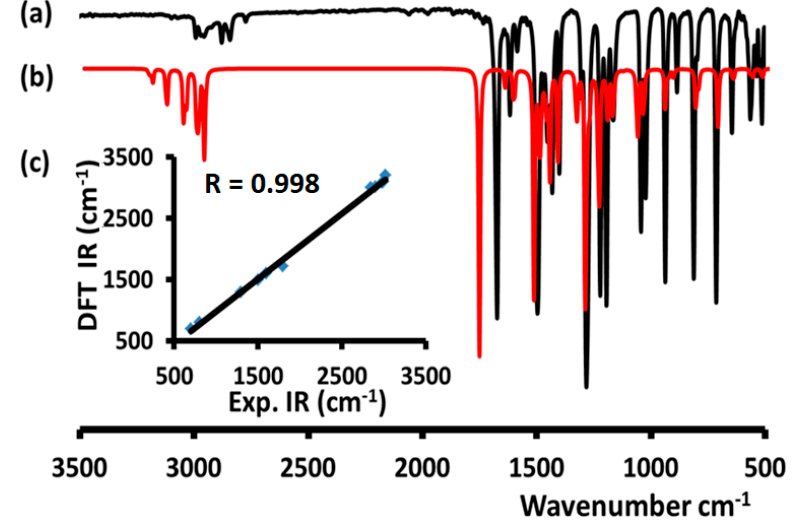
Figure 9. ( a ) Experimental and ( b ) DFT-calculated FTIR spectra of 2,5-dimethoxybenzaldehyde, and ( c ) their graphical correlation.